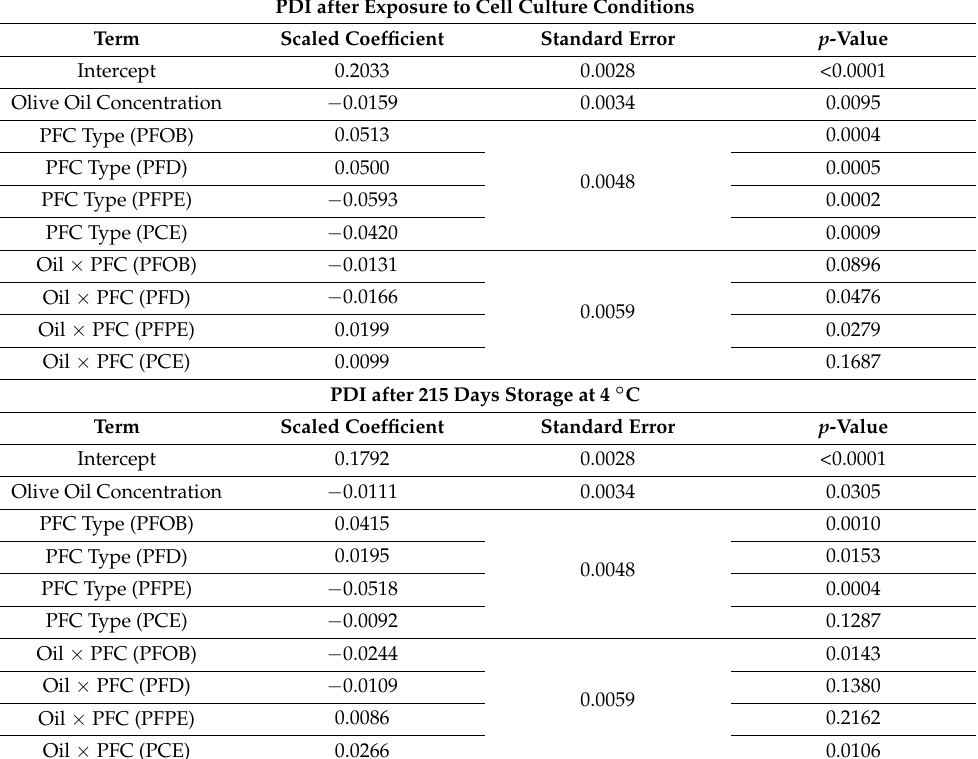
Table 6. Parameter scaled coefficients, standard errors, and p -values for MLR models developed to predict nanoemulsion PDI after exposure to cell culture conditions (top) and after storage at 4 ◦ C for 215 days